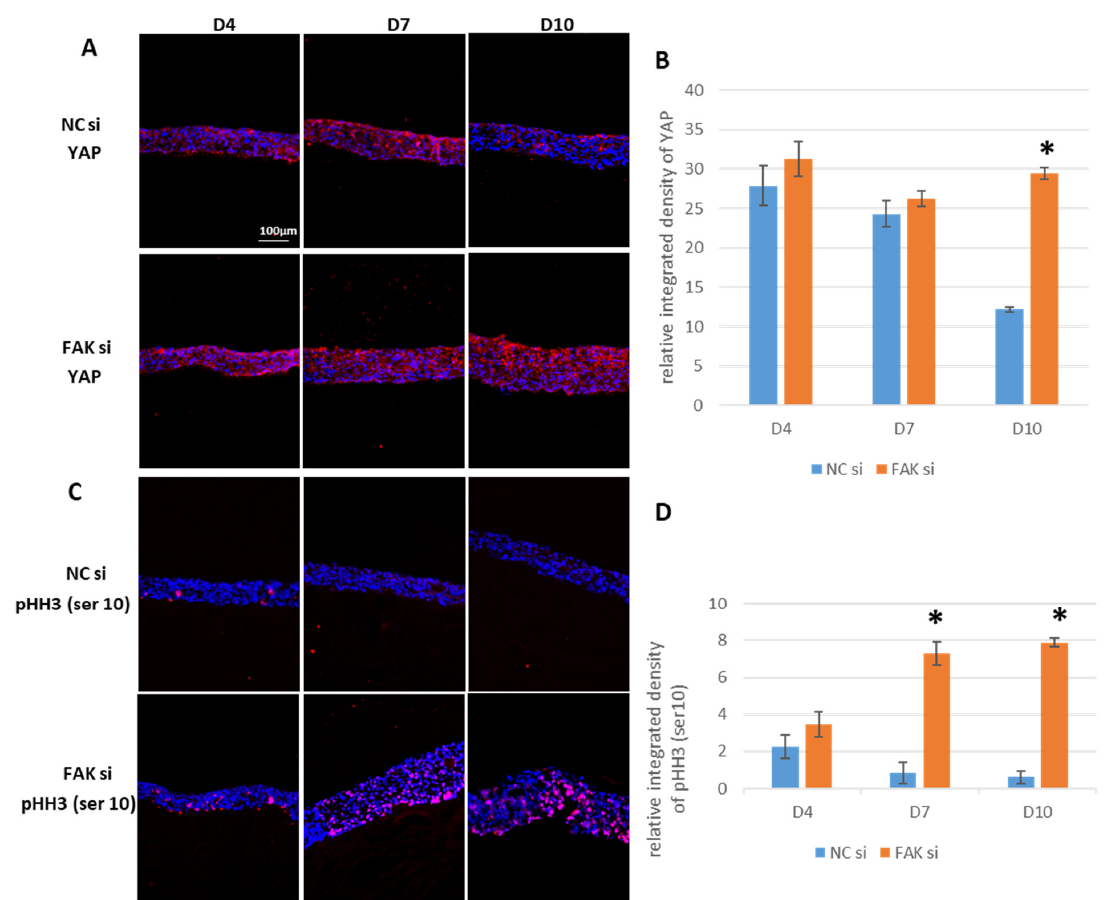
Figure 7. siRNA-mediated inhibition of FAK in GK-based cocultures and the influence on vinculin and ROCK-II expression and distribution. Cells were transfected with FAK-siRNA and incubated for 48 h before usage in the coculture setup for a further 4, 7, or 10 days. Shown in ( A ) are representative IIF images of cryofixed sections of FAK-siRNA-treated versus nontreated cocultures stained with an anti-vinculin Y1065 antibody after the indicated periods of time. Similarly, ( C ) depicts representative IIF images of cryofixed sections of FAK-siRNA-treated versus nontreated cocultures, stained with an anti-pROCK-II Ser1366 antibody after the indicated periods of time. The bar graph in ( B ) represents the SQFI by measuring the relative integrated fluorescence density of the vinculin fluorescence signal. Likewise, ( D ) shows the pROCK-II Ser1366 fluorescence signal and compares the FAK-siRNA inhibited coculture with the noninhibited control. ( n = 3 for all experiments, values are depicted as mean +/ − SEM; * = p < 0.05. Scale bars represent 100 µm. NC = negative control; D = day).